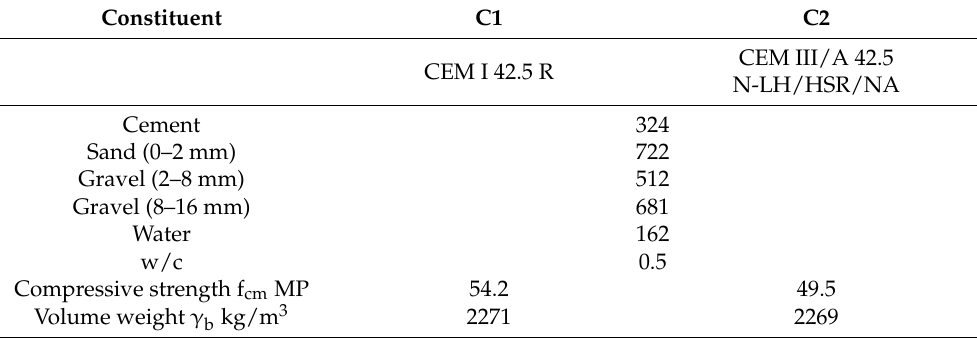
Table 1. Composition, Properties and compressive strength of concrete mixtures.